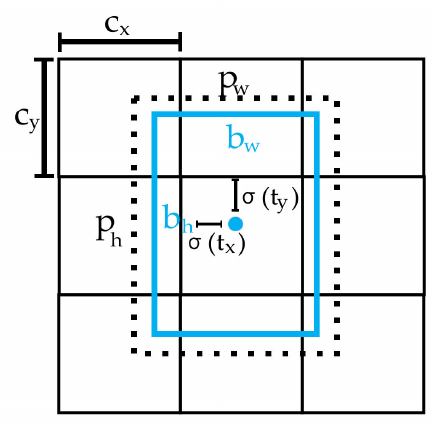
Figure 4. Target object’s position in the